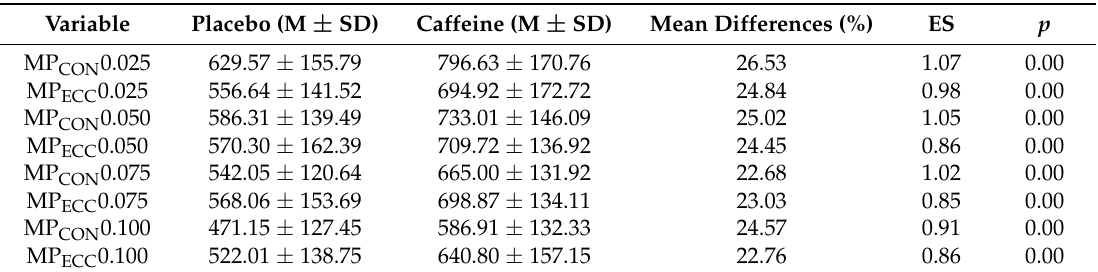
Table 1. Effects of caffeine ingestion on concentric (CON) and eccentric (ECC) mean power (MP) outcomes (W) at different inertias compared to the placebo condition.